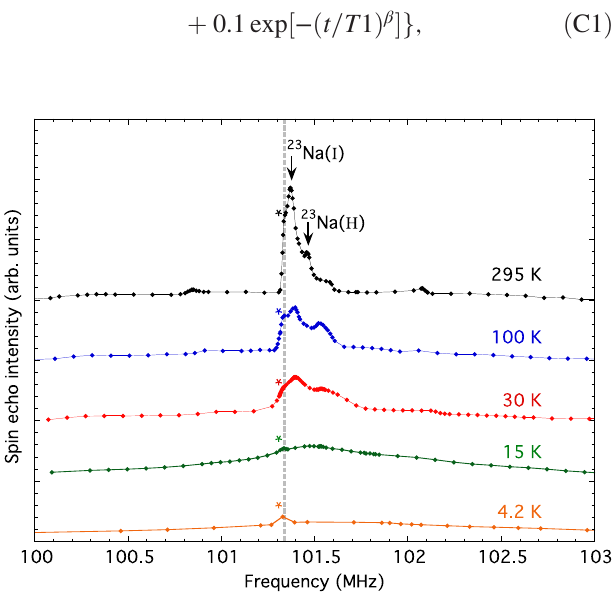
FIG. 17. 23 Na powder NMR line shapes observed at B 9 T for Na 2 IrO 3 . The gray dashed vertical line marks the unshifted 23 Na frequency 23 ν o . The hump marked with * is an unshifted 23 Na signal from a small amount of magnetically inert impurity